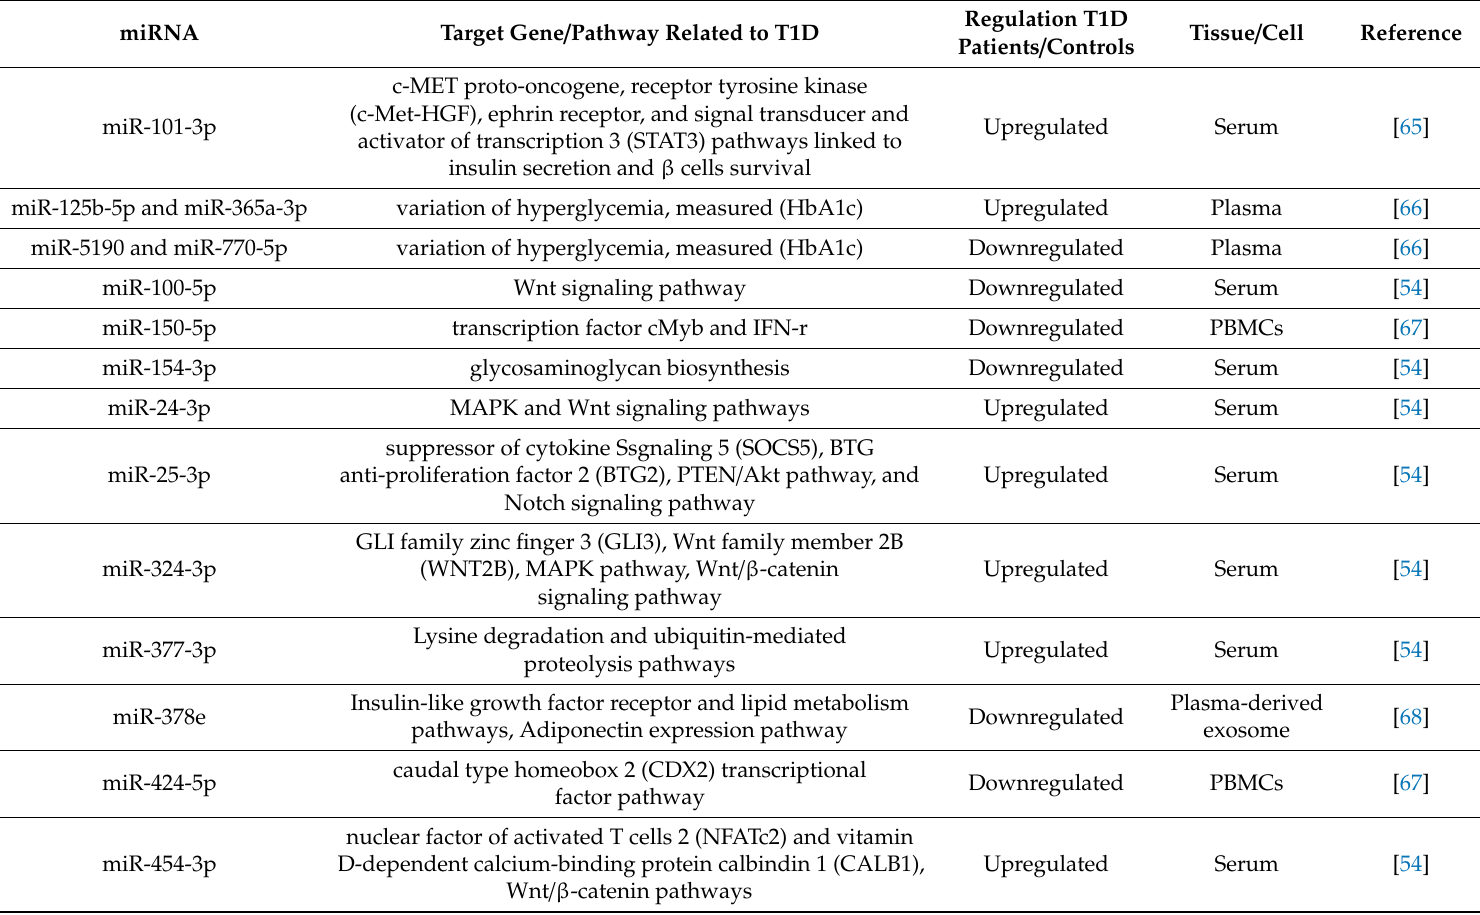
Table 1. miRNAs that are di ff erentially expressed between type 1 diabetes (T1D) patients and una ff ected controls, targeting the drivers of epigenetic modification in